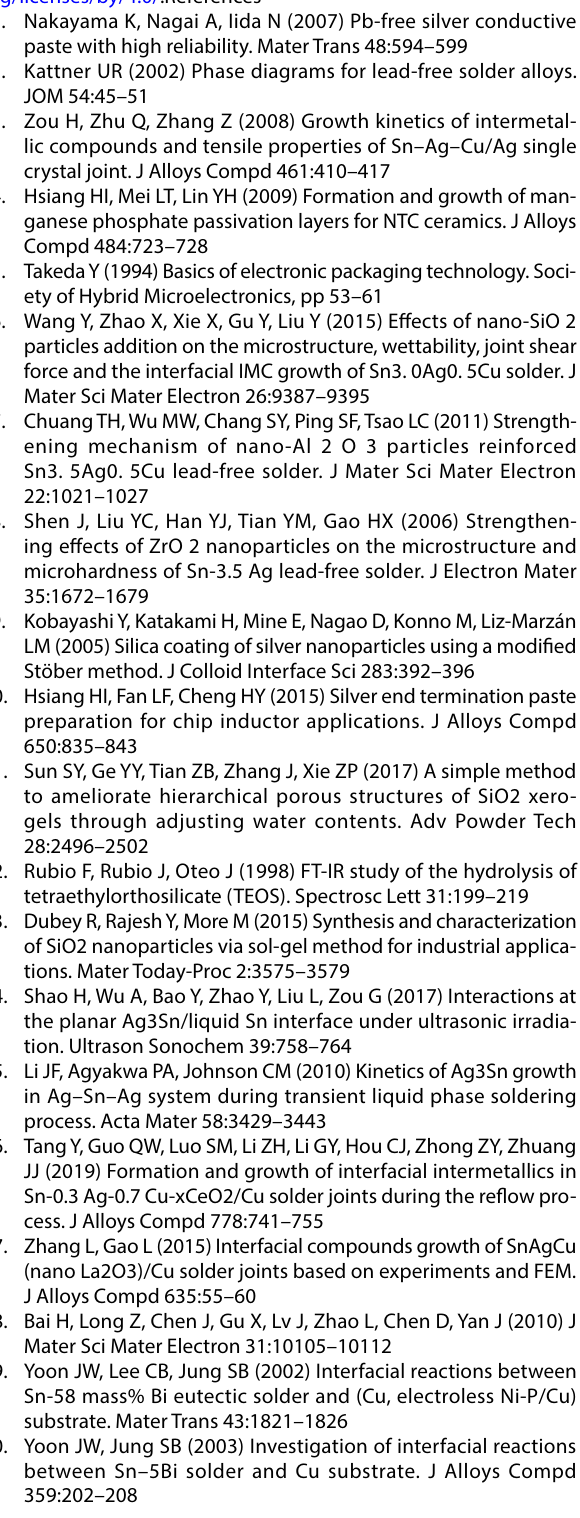
Table 7 Activation energies of interfacial IMC growth for samples coated with TEOS and reacted for 24 h and 48 h after soldering Reaction